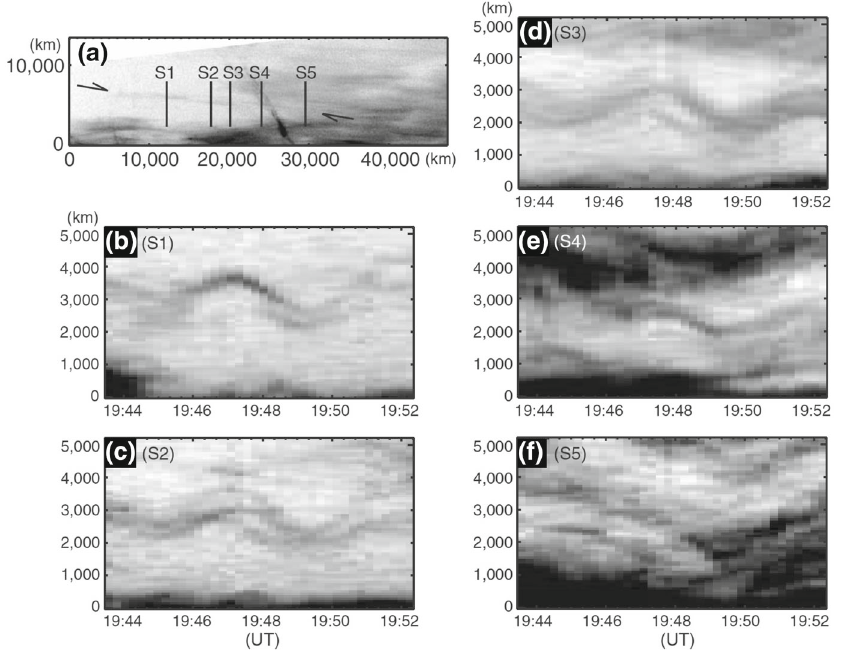
Fig. 31 Example of a prominence thread undergoing synchronous oscillations along its entire length (all images are shown in negative contrast). a The ends of the considered thread are marked by the two arrows. S1 – S5 indicate the locations used to make the height versus time plots shown in ( b )–( f ). b – f Height-time plots for the locations indicated in ( a ). Maximum and minimum amplitudes occur at nearly the same time for all locations. Image reproduced with permission from Okamoto et al. (2007), copyright by